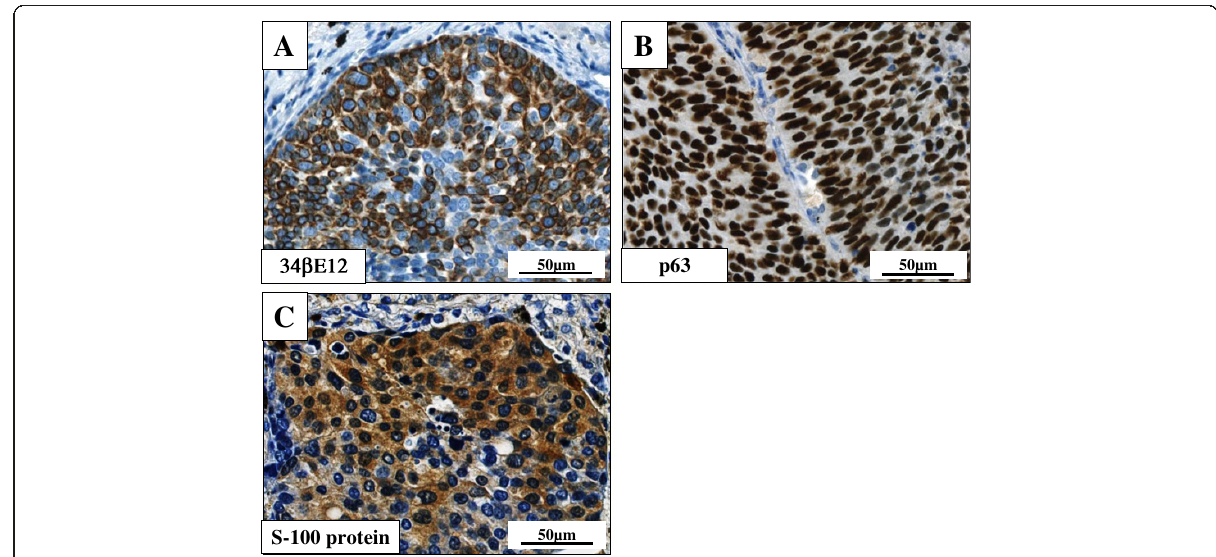
Figure 4 Immunohistochemical examination of the BC of the lung. ( A , B , C ) The carcinoma cells of BC were specifically positive for 34 β E12 (A) and p63 (B). Additionally, one part of tumor nests was positive for S-100 protein (C). Bars = 50 μ m.